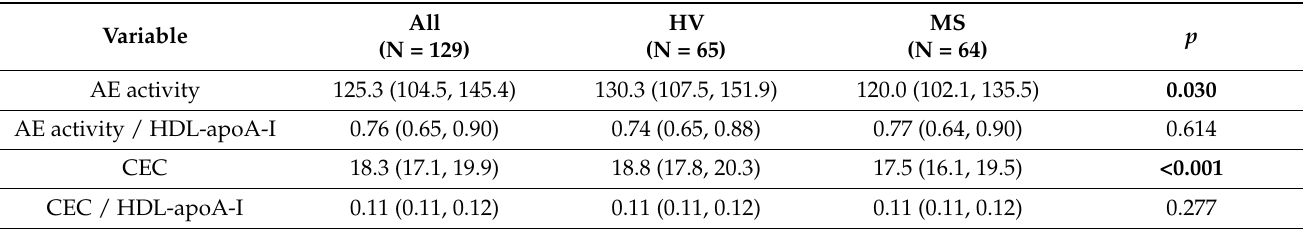
Table 5. Differences in metrics of HDL function between HV and MS